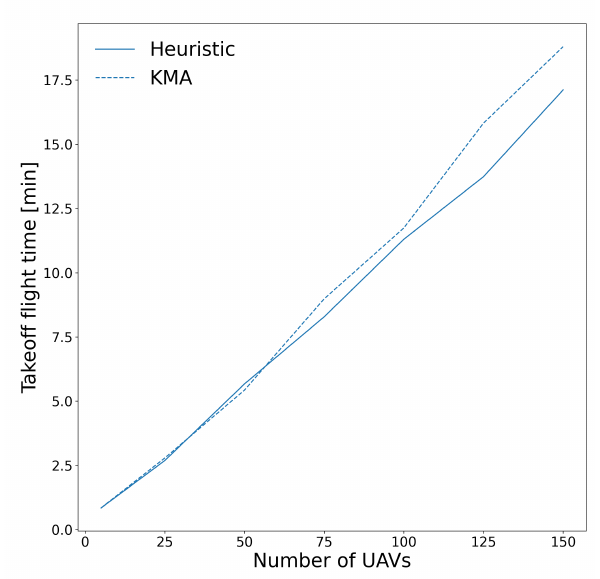
Figure 24. Take-off flight time between heuristic and KMA in the linear formation.